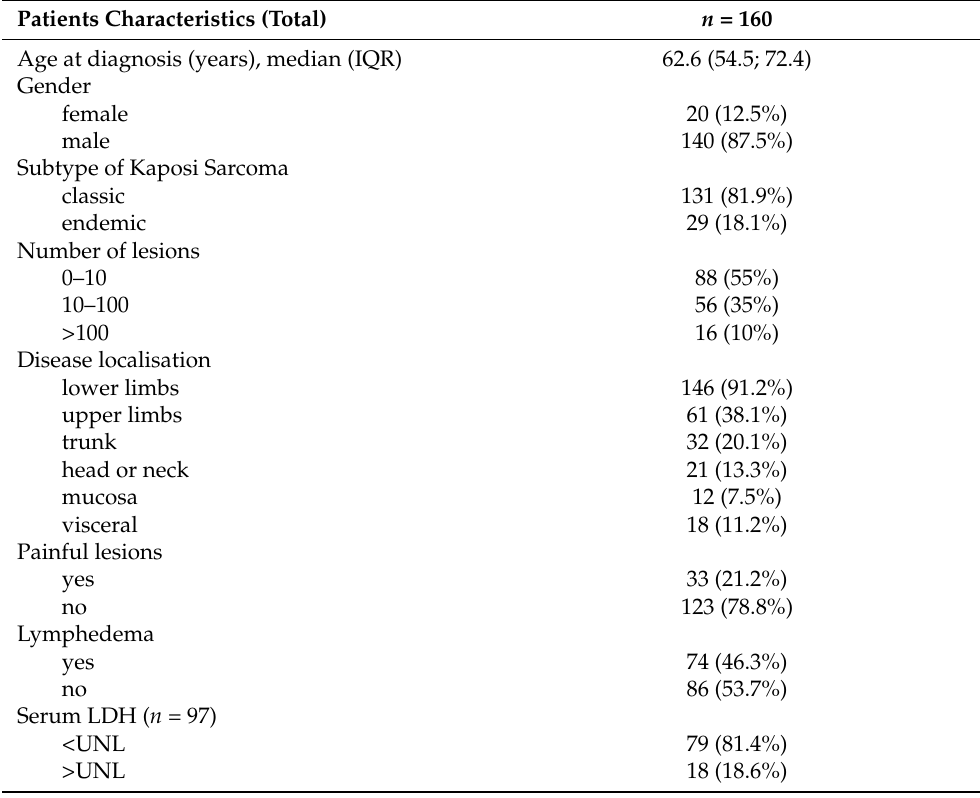
Table 1. Patients’ characteristics at KS diagnosis. UNL: Upper Normal Limit. IQR: Inter-Quartile Range. LDH: Lactate